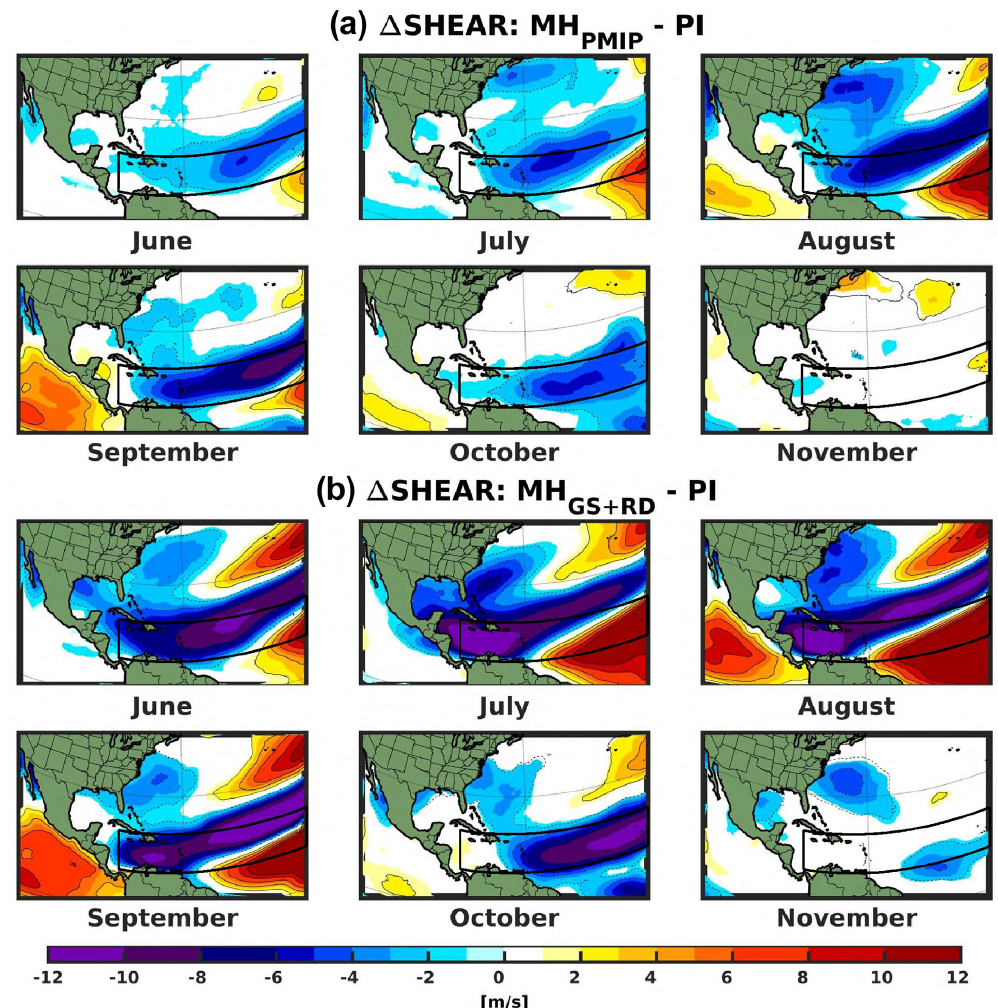
Figure A12. Monthly mean changes in climatological wind shear (200–850hPa) for the (a) MH PMIP and (b) MH GS + RD experiments relative to PI. The black box shows the approximate present-day MDR. Only values that are significantly different at the 5% level using a local (grid-point) t test are shaded. The contour lines follow the color-bar scale (dashed, negative anomalies; solid, positive anomalies); the 0 line is omitted for